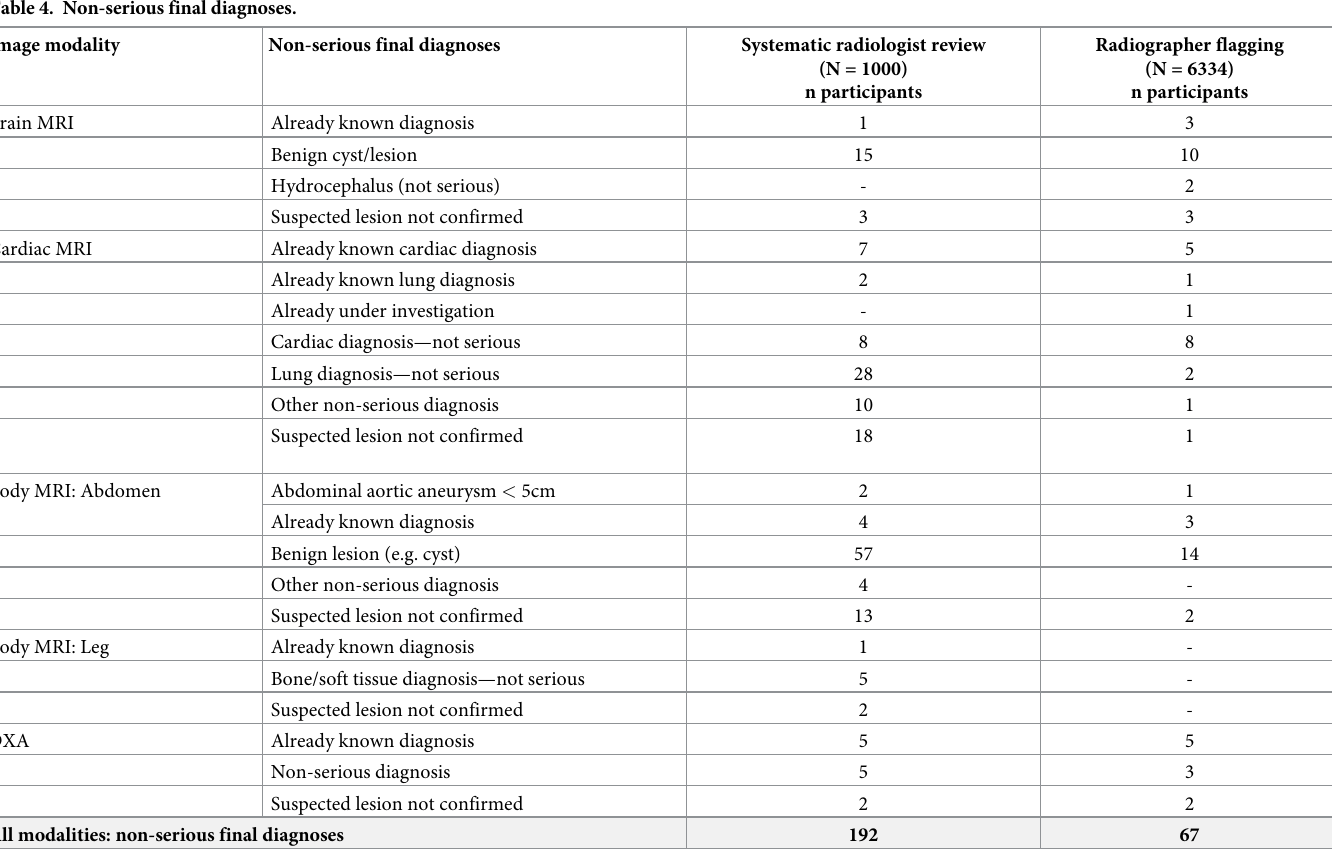
Table 4. Non-serious final diagnoses.